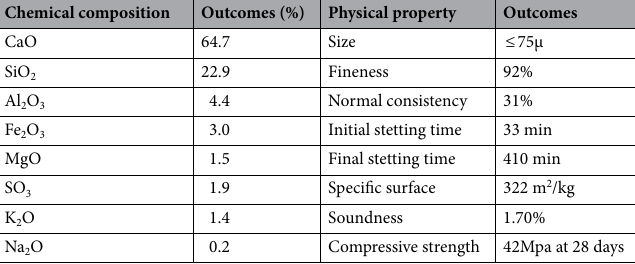
Table 1. Properties of cement.